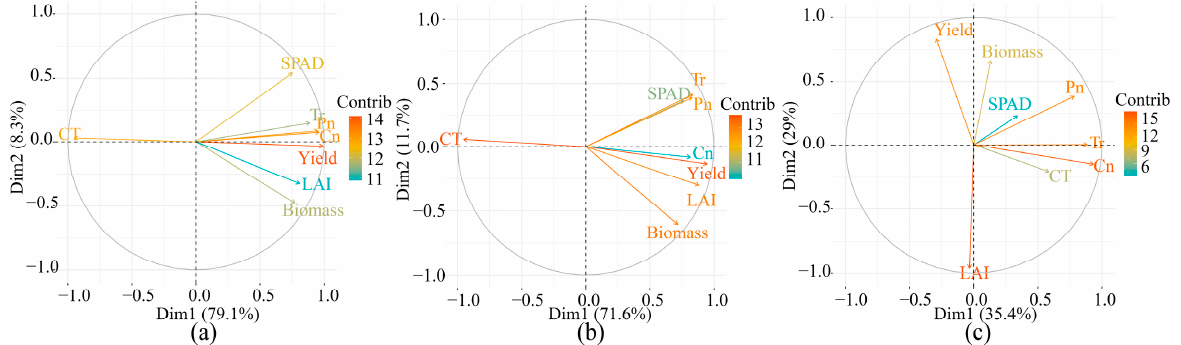
Figure 8. PCA correlation circle with vectors for each variable on the first two principal components (Dim 1 and Dim 2) showing the association between canopy temperature and physiology traits and the contribution of Dim 1 and Dim 2 to the model at different water treatments (W0, W1 and W2), and the lengths and colors of the vectors represent the total contribution of the variable to the first two principal components. This PCA was based on final biomass and yield as well as physiological traits and canopy temperature on May 20: ( a ) W0, no irrigation during the growing season, ( b ) W1, irrigation at jointing, ( c ) and W2, irrigation at jointing and